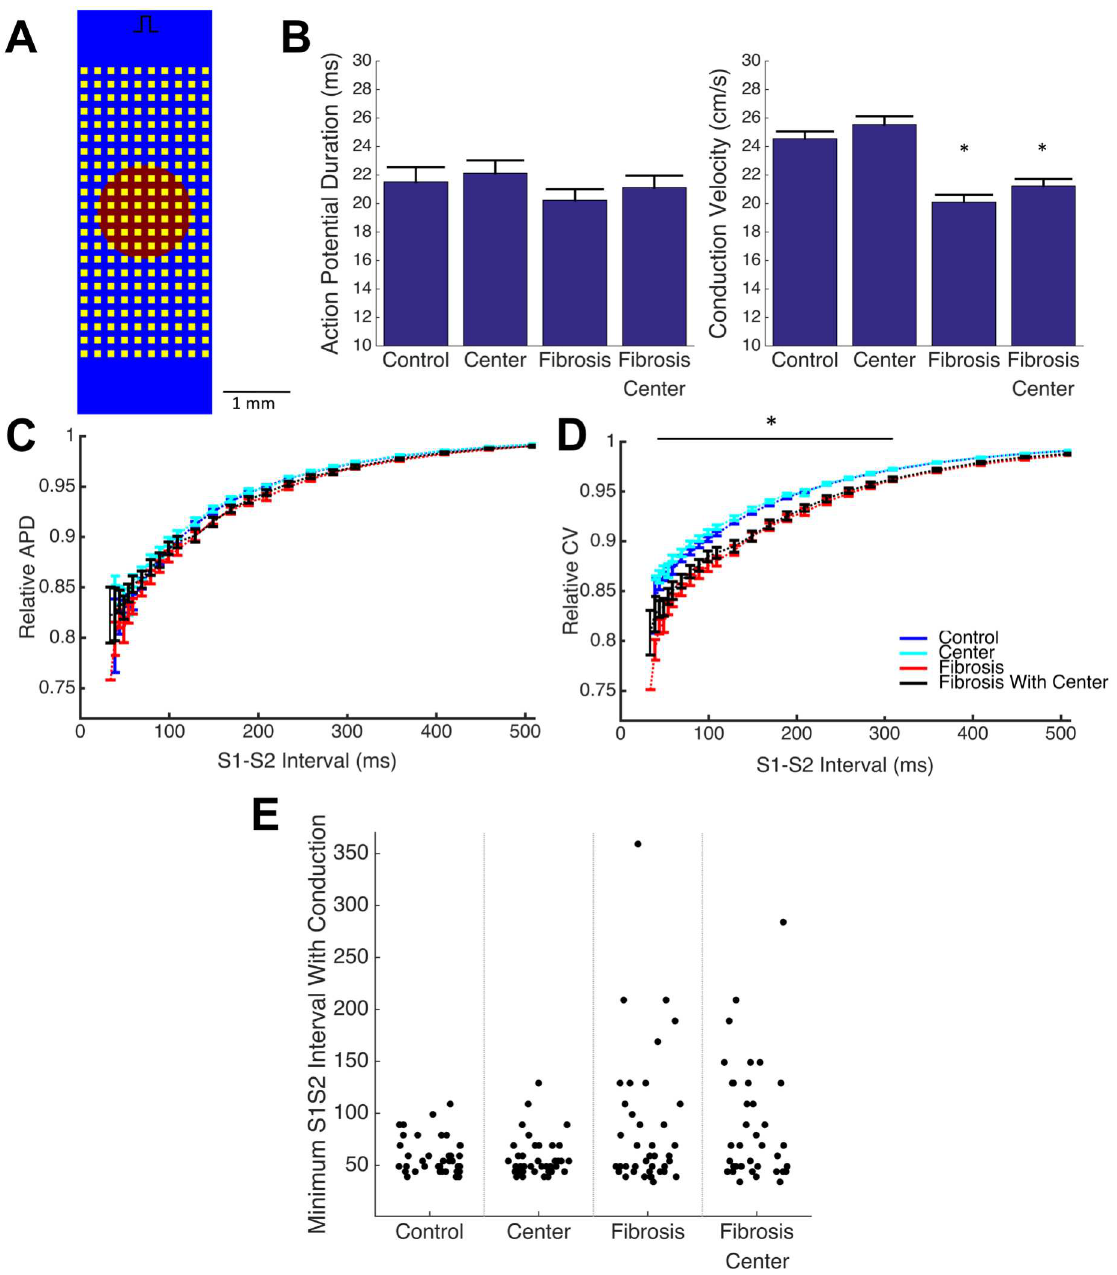
Fig 8. Spatial organization of ionic variation does not affect macroscopic conduction. The introductionof a central region with reducedvarianceand prolongedAPD (A, red) into a tissue model with and without non-conductive fibrosis-like obstacles (A. yellow)does not cause additionalconductionslowingand APD shorteningat 1 Hz pacingbeyond the effect of fibrosis alone (B). A fibrosis inducedexaggeration of CV slowing(D), but not APD shortening (C), at short diastolic (S1-S2) intervals (plotted as mean +/- standarderror) is also unaffected by the spatialorganizationof variation. In addition,spatialorganizationmaintainsbut does not enhancepremature failure, as characterized by minimumS1-S2 intervals able to fully conduct across the domain(E). ( * p < 0.05 main effect of fibrosis)